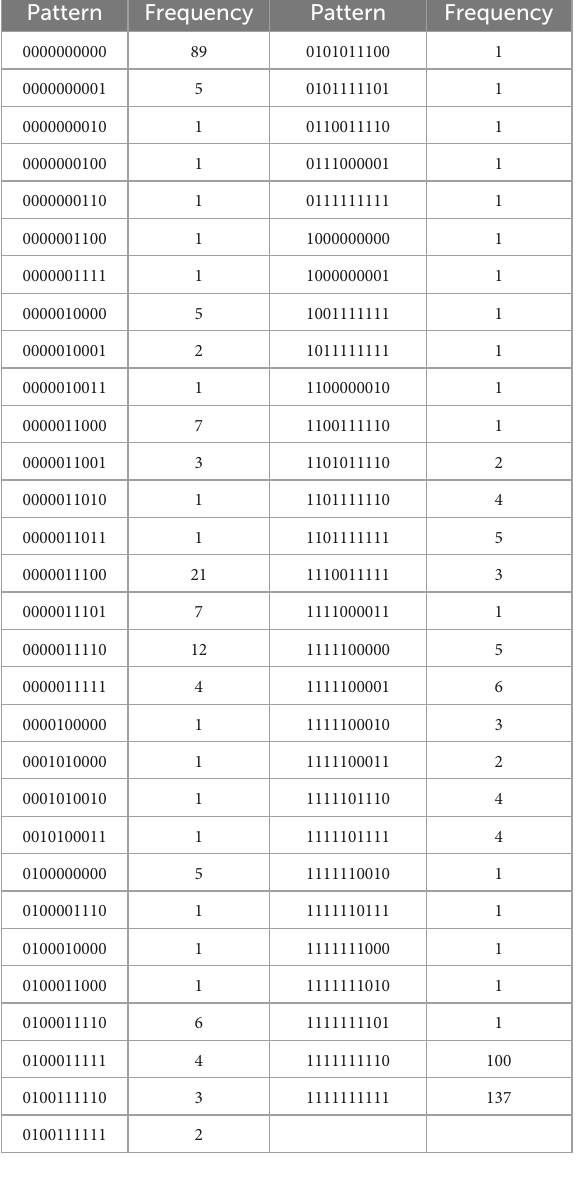
TABLE 4E Autonomous motivation, with N = 482, k = 10 items, and u = 59 unique response patterns ( Appendix B ). Pattern